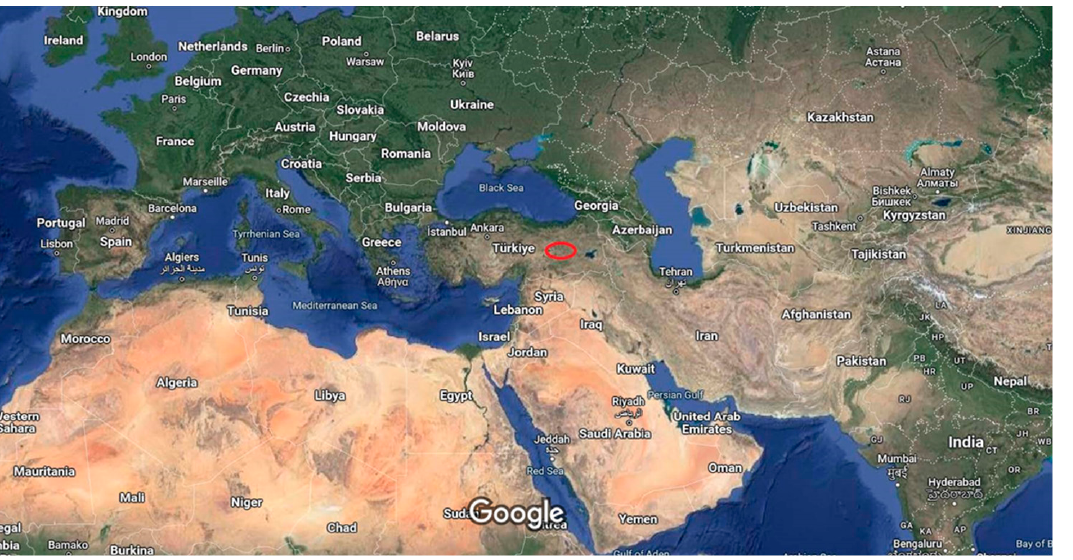
Figure 2. Graph of pollen’s morphological measurements of the studied taxa. 0